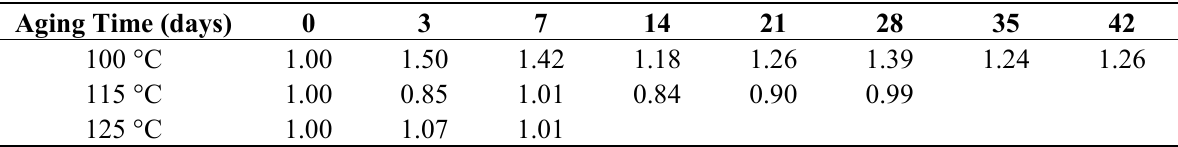
Table A7. Modulus of elasticity of the nanolayered film with 4,094 layers of 31 nm thick (Type 4 film in Table 2) aged at temperatures of 100 °C, 115 °C and 125 °C. The data were normalized by the pristine material properties.